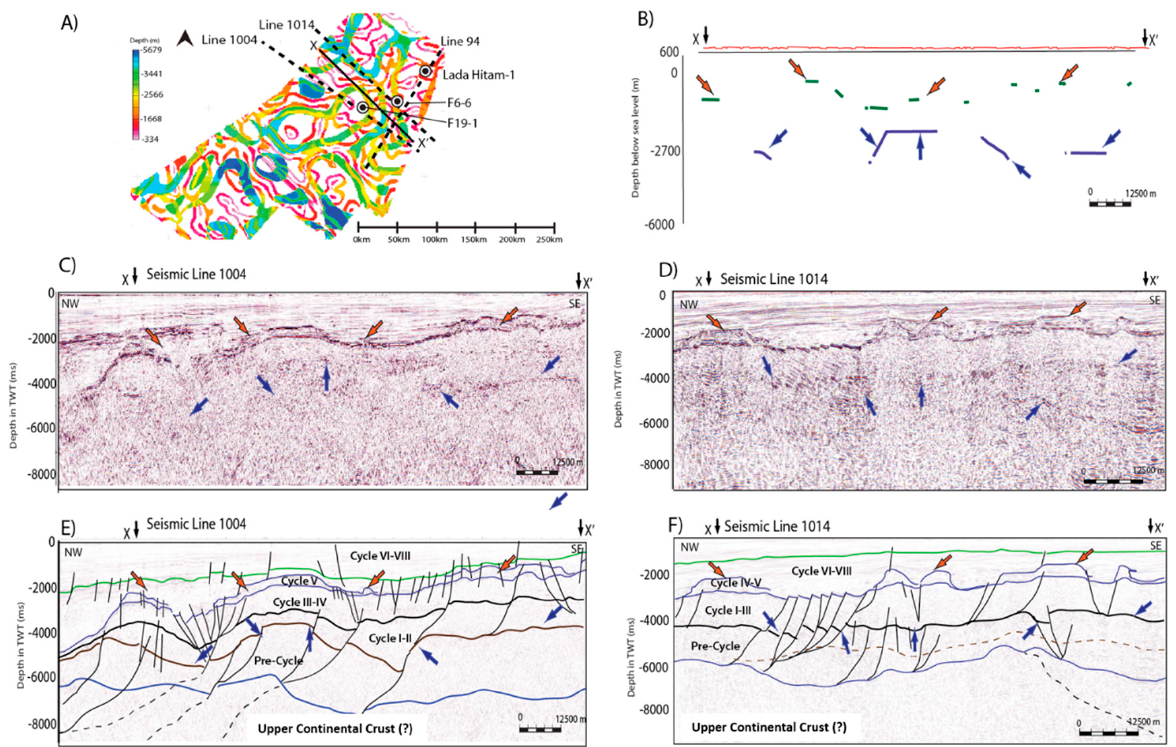
Figure 11. ( A ) Location of the depth profile X-X’ and seismic lines 1004 & 1014. ( B ) Depth profile X-X’ oriented in NW-SE. ( C , D ) Uninterpreted seismic sections for line 1004 and 1014 respectively. ( E , F ) Interpreted seismic for line 1004 and 1014, respectively. The blue and orange arrows are highlighting similar features pointed on the depth profiles and on seismic data. The seismic lines are marginally longer than the depth profile X-X’. The interception point for the depth profiles and seismic lines are pointed by black arrow at the top of images in ( B – F ).